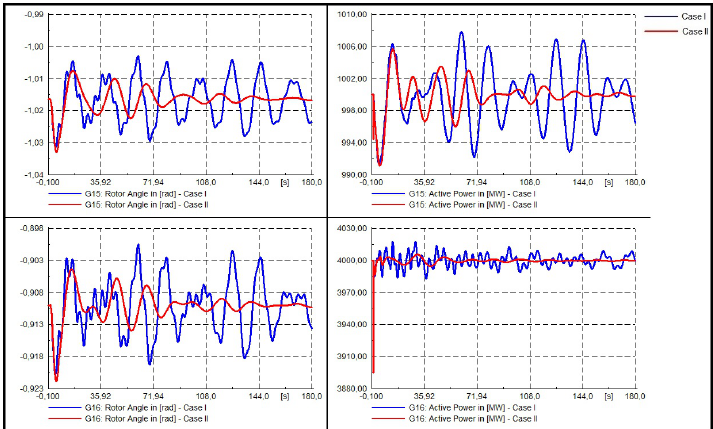
Figure 32. Rotor angle [rad] and Active Power [MW]-three phase fault at Line 60–61.